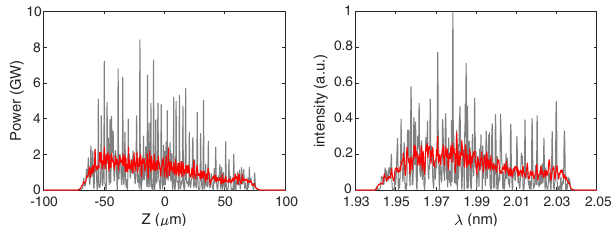
FIG. 7. Simulated FEL power profile (left) and spectrum (right) of the selected electron bunch. The gray lines refer to a single shot and the red lines represent average values of 20 runs with different seeds.